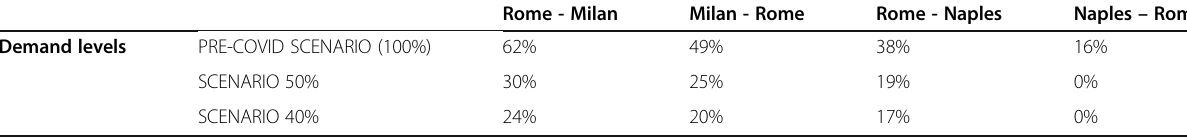
Table 2 Percentages of passengers lost by HSR undertakings, in the simulated scenarios, for each